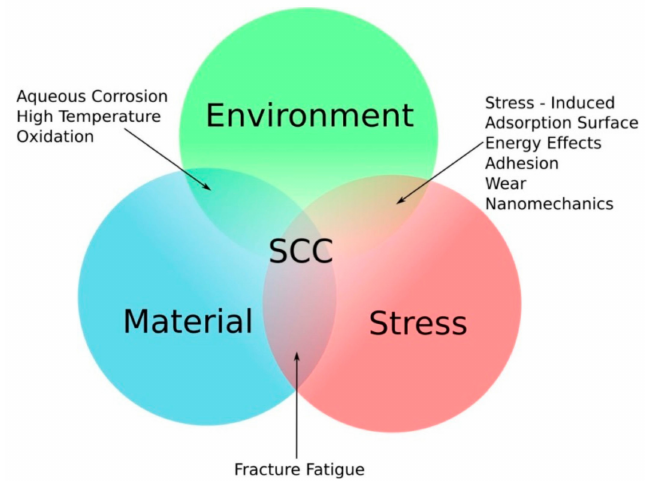
Figure 1. The relationship between stress, the environment, and susceptible material, modified from McCa ff erty